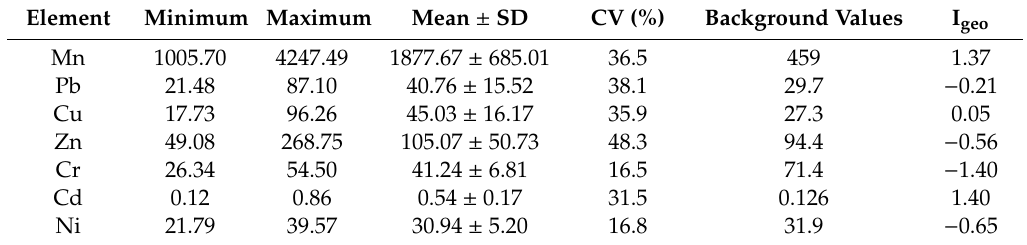
Table 1. Potentially toxic elements (PTEs) concentrations and descriptive statistics in the soil (mg / kg). Element Minimum Maximum Mean ± SD CV (%) Background Values I geo Mn 1005.70 4247.49